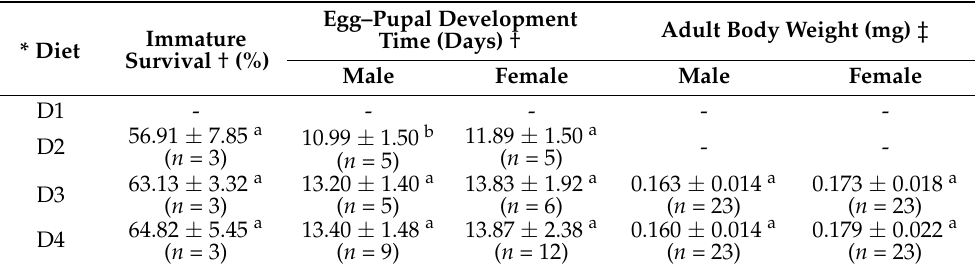
Table 1. Mean ± SE of the immature survival, developmental time, and adult body weights of S . gilvifrons fed four different diets containing A . franciscana